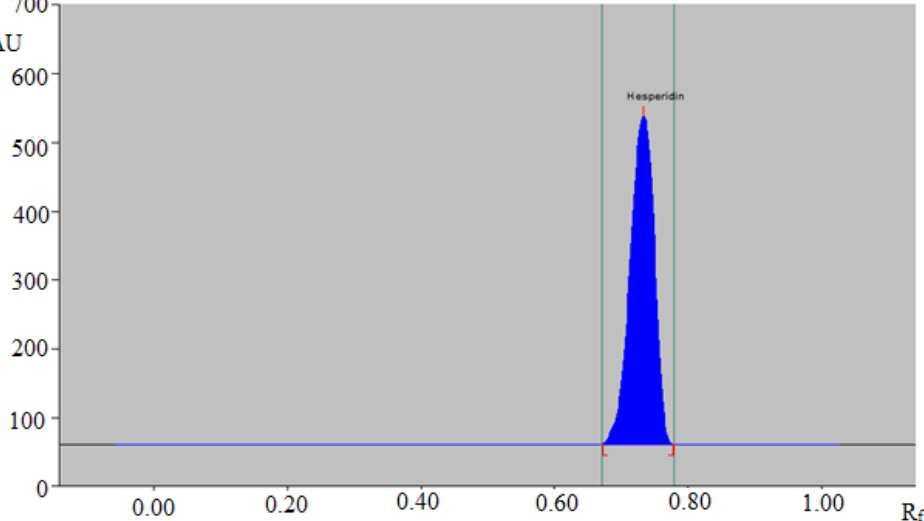
Figure 2. Representative spectrodensitogram of standard HSP for the sustainable RP-HPTLC